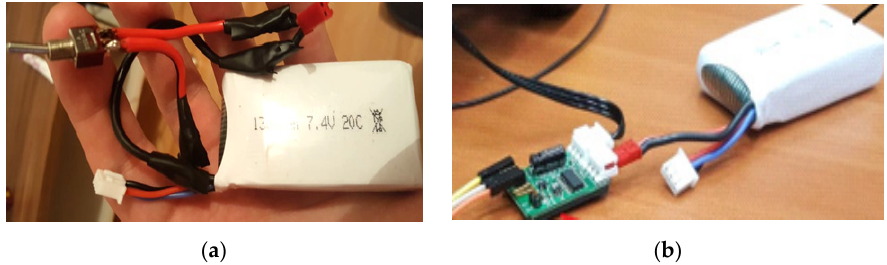
Figure 5. Different types of electric accumulator connection to the robotic arm application for testing: ( a ) accumulator connected to the robotic arm through a switcher; ( b ) connection to the TTLinker board. For testing the operational capability of the robotic arm in the public health service and industry, it was installed on a mobile platform, as shown in Figure 6.